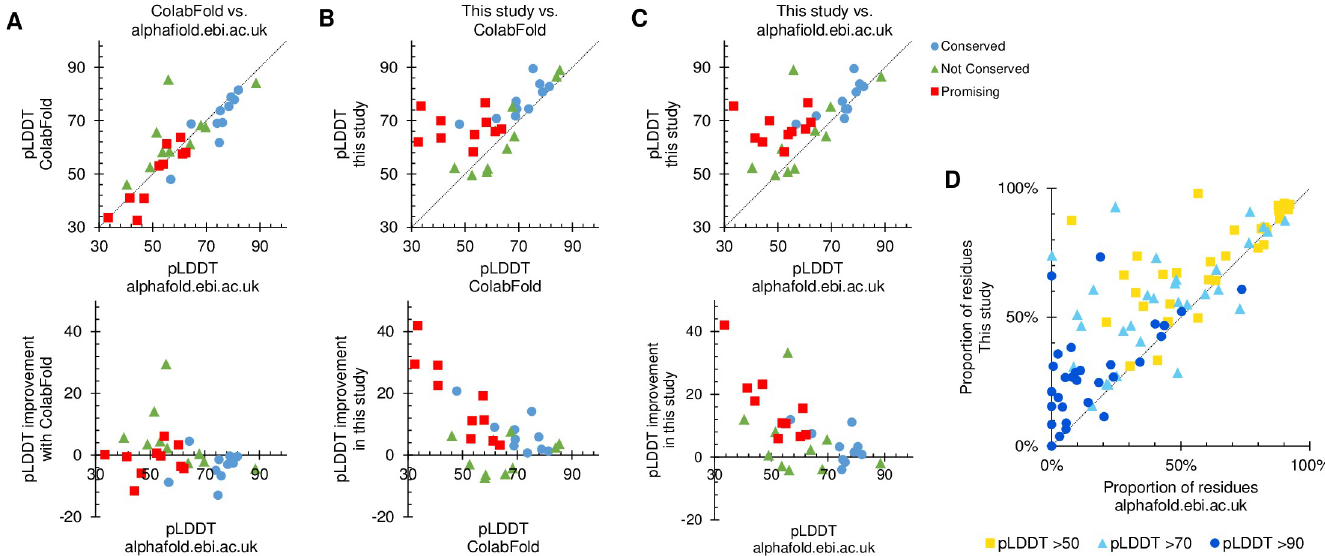
Fig 2. Improved AlphaFold2 predictions using ColabFold and a wider set of Discoba sequences for MSAs. A-C) Comparison of per-protein average pLDDT for 30 test proteins, 10 random widely conserved proteins, 10 random kinetoplastids-specific proteins and 10 ‘promising’ kinetoplastid-specific proteins which appeared likely to improve with additional MSA sequences. A) Unmodified ColabFold in comparison to the AlphaFold database plotted as: Top, raw pLDDTs. Points to the top left of the diagonal represent improved (higher pLDDT) predictions. Bottom, change in pLDDT. Points above the horizontal axis represent improvement. B) This study (ColabFold with HMMER search of additional Discoba sequences) in comparison to unmodified ColabFold. C) This study in comparison to the AlphaFold database. D) The same comparison as C) but plotting the proportion of residues over different threshold pLDDT values instead of mean pLDDT.